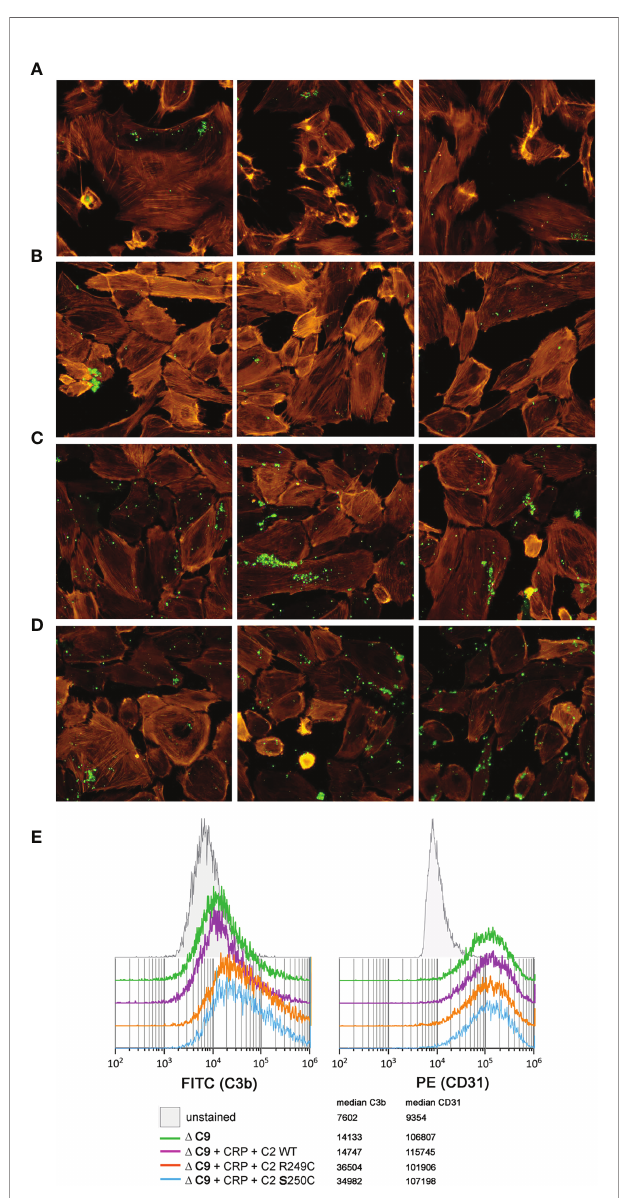
FIGURE 3 | C3b deposition on glomerular endothelial cells. Immortalized glomerular endothelial cells were seeded onto glass chambers and exposed to C9-depleted human serum ( D C9) in order to prevent lysis. Deposition of C3b (green) was analyzed by fl uorescent microscopy (A – D) when nothing (A) , CRP + WT C2 (B) , CRP + R249C variant (C) , or CRP + S250C variant (D) was added. Labeled phalloidin (orange) was used as a counterstaining. Three independent images are shown for each condition. (E) To perform an alternative, quantitative analysis that con fi rms the observed pattern of immuno fl uorescence, cells were harvested and examined by fl ow cytometry for both C3b deposition (left histogram) and CD31 expression (right histogram). Results show 10,000 events, previously gated to eliminate cell doublets and cell